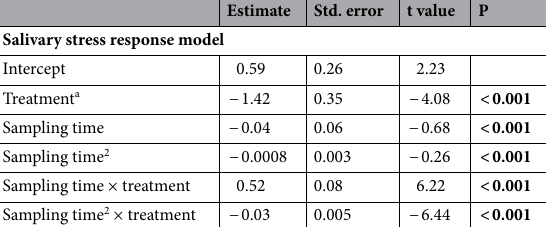
Estimate Std. error t value